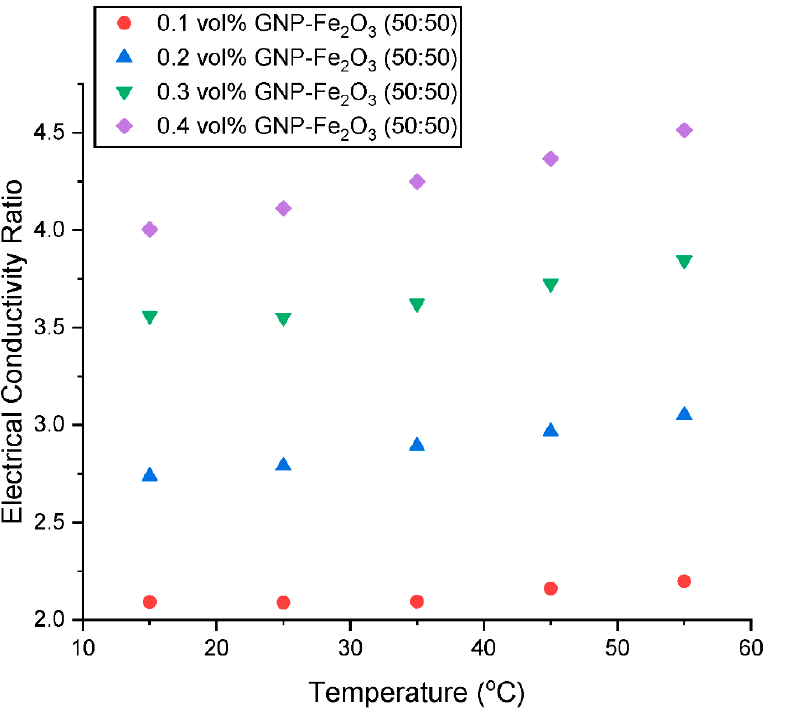
Figure 16. Influence of temperature on the electrical conductivity ratio of the hybrid nanofluids at various concentrations.